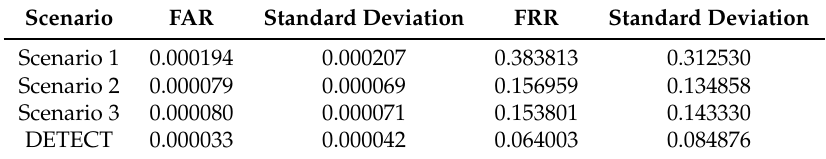
Table 3. Mean FAR and FRR values and standard deviation in each data improvement models.